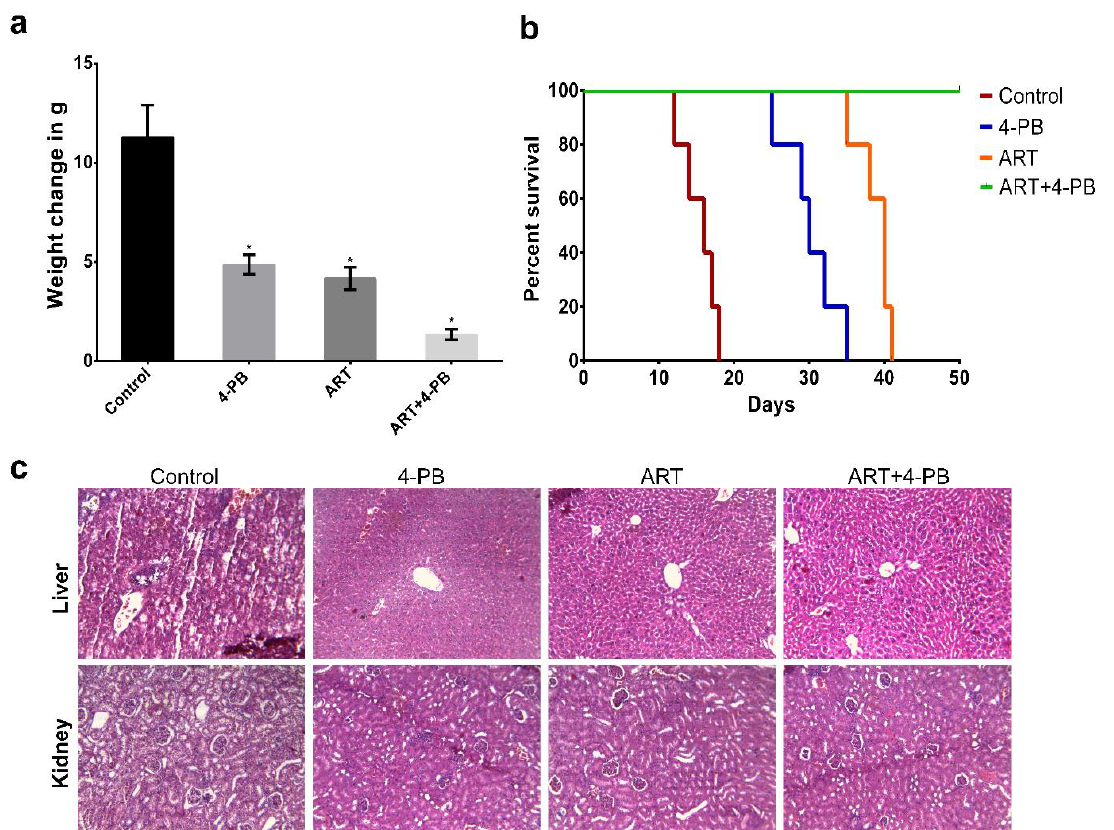
Figure 6. In vivo assessment of the combination drug treatment. ( a ) Reduction in the weight of the mice indicates reduction in volume of the tumour. The effect of drugs on the tumour volume after 15 days of DLA induction and seven days of drug treatment were investigated by weighing mice at different time intervals. ( b ) Changes in the lifespan of the mice were analysed after calculating the percent survival fraction of the mice after treatment. The percent survival curve is plotted using the Kaplan-Meier curve. ( c ) Histopathological analysis of liver and kidney tissues of mice (magnifica- tion 20X). * p < 0.05.